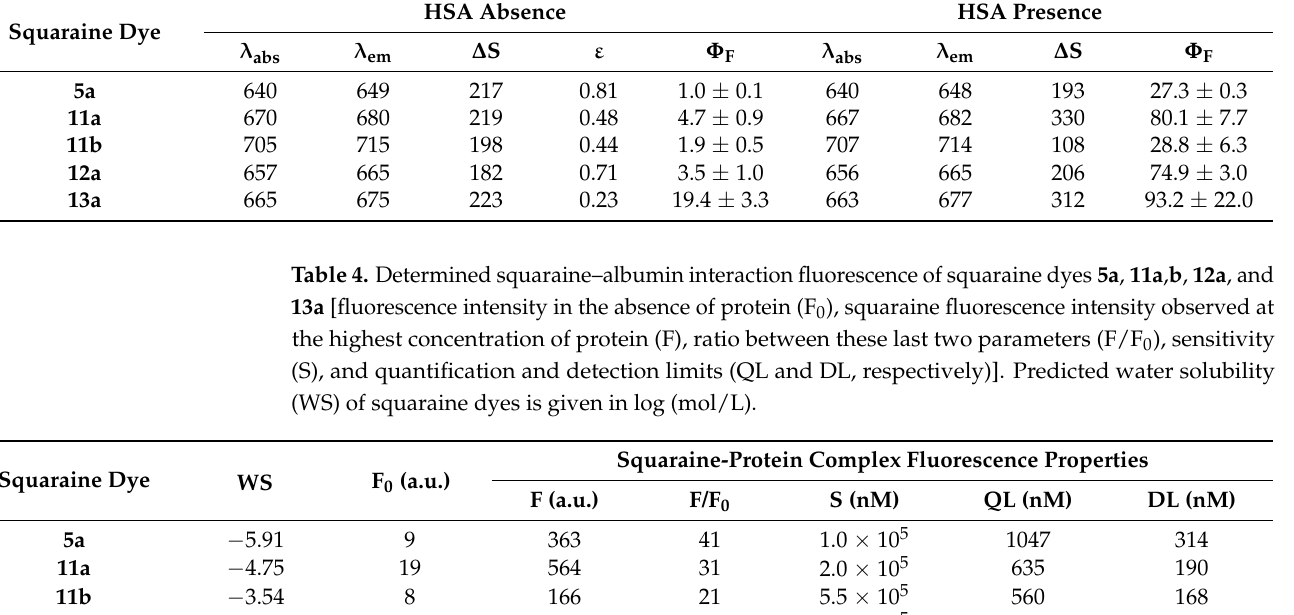
Table 3. Differences observed in the absorption and fluorescence properties of squaraine dyes 5a , 11a , b , 12a , and 13a in phosphate buffer in the absence and presence of human serum albumin (HSA). The maximum absorption and emission wavelengths ( λ abs and λ em , respectively), as well as the Stokes shift ( ∆ S), are given in cm − 1 , the molar absorptivity coefficients ( ε ) are shown in × 10 5 M − 1 · cm − 1 , and the relative fluorescence quantum yields ( Φ F ) are given in percentages. HSA Absence HSA Presence